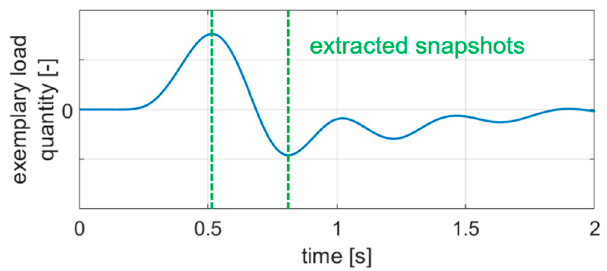
Figure 9. Extracted snapshots from a gust encounter.